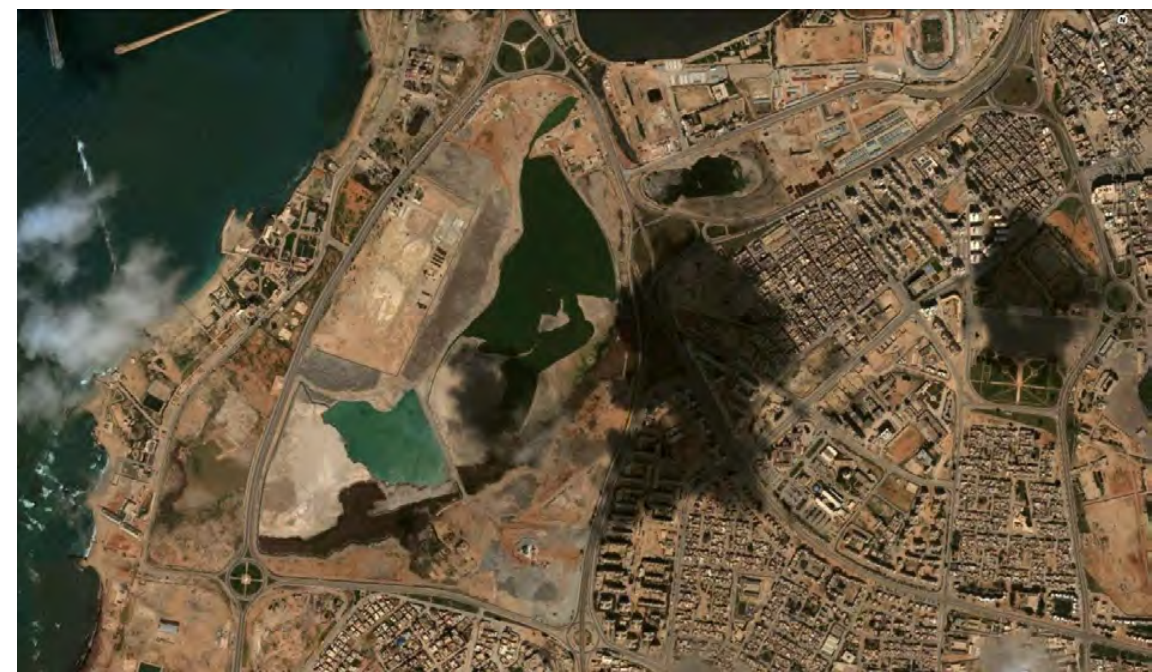
Figure 7. Juliana Lake: A Benghazi Wetland In Distress, Available from: Mansour M Elbabour, EGU General Assembly,2013